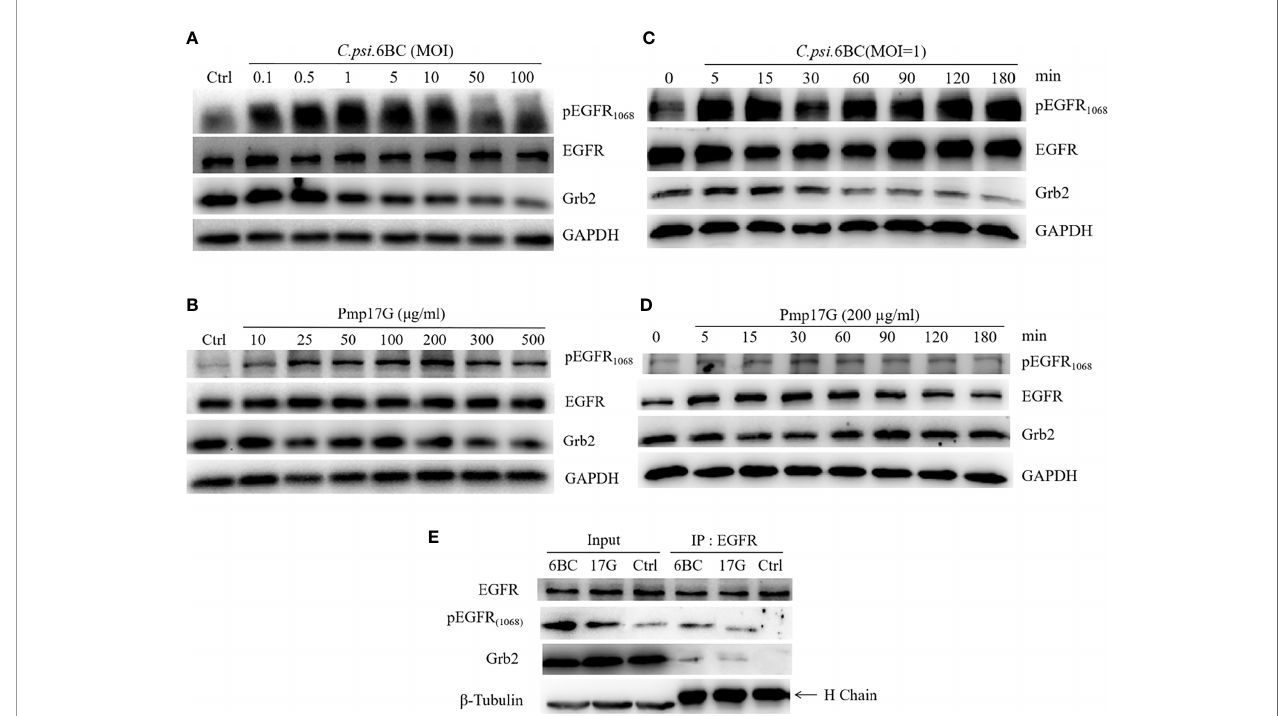
FIGURE 6 | Pmp17G stimulated the phosphorylation of EGFR and downregulated Grb2 expression. (A) HeLa 229 cells were infected with serial doses of C. psittaci (MOI from 0.1 to 100), and the expression of EGFR, pY1068-EGFR and Grb2 was identi fi ed using Western blots. (B) HeLa 229 cells were treated with serial doses of Pmp17G (from 10 m g/ml to 500 m g/ml), and the expression of these proteins was determined using Western blots. (C) HeLa 229 cells were infected with C. psittaci (MOI=1.0), and the expression of the aforementioned proteins was identi fi ed at different time points (at 5, 15, 30, 60, 90, 120, and 180 min) by Western blots. (D) HeLa 229 cells were treated with 200 m g/ml of Pmp17G, and the expression levels of these proteins were determined at different time points. GAPDH was used as the loading control. (E) Grb2 recognized pY1068-EGFR by Co-IP assay. HeLa cells were treated with C. psittaci 6BC (MOI=1.0) or 200 m g/ml of Pmp17G, and IP was performed with anti-EGFR mAbs for 0.5 h at 4°C. Then, IP compounds were incubated with anti-EGFR, anti-pY1068-EGFR or anti-Grb2 antibodies, respectively and identi fi ed by Western blot assay. b -Tubulin was used as the loading